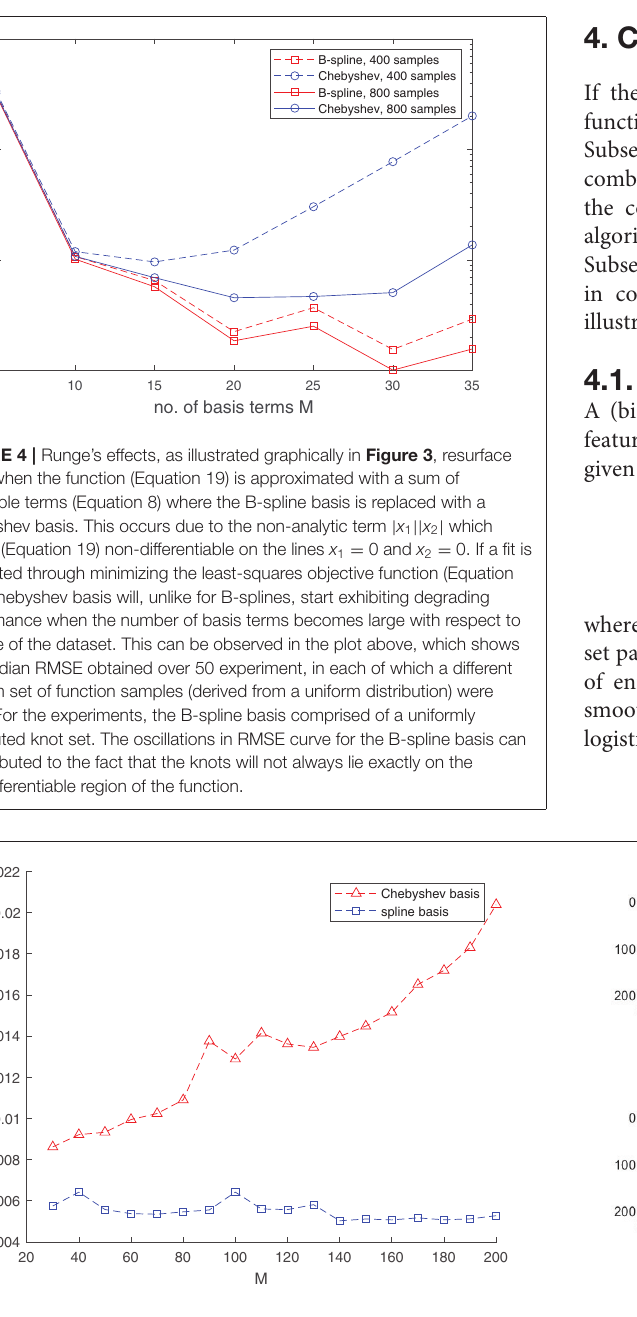
significantly accelerates the GN step. The left plot shows B ( d ) ⊤ ( x 1, d ) B ⊤ ( d ) ( x I , d ) = ··· 4 and a Chebyshev basis. We used 1,000 h i = 3. The right plots provide a glimpse of the sparsity structure of the matrix A ( d ) for a specific =